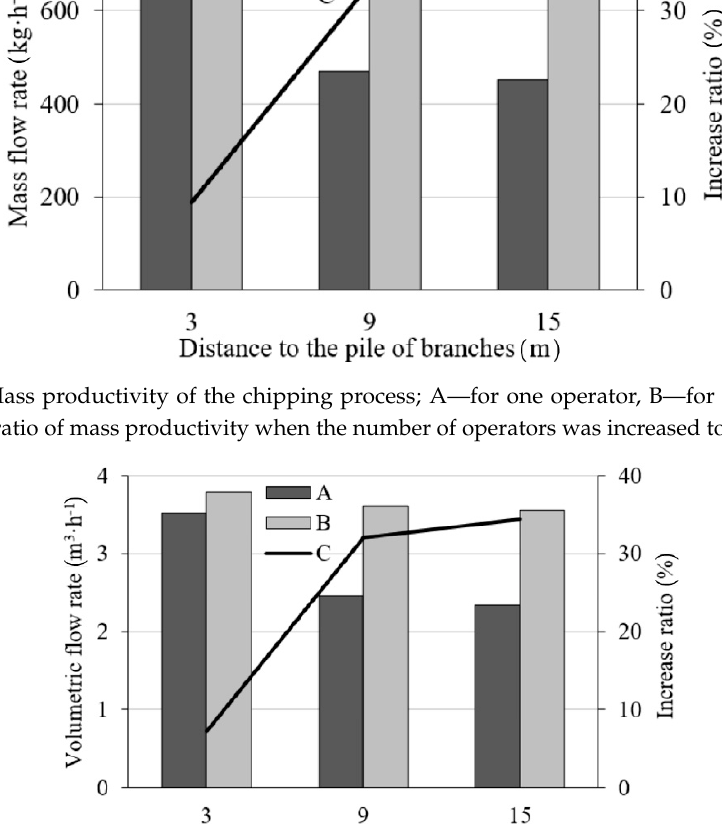
Figure 11. Volume productivity of the chipping process; A—for one operator, B—for two operators,